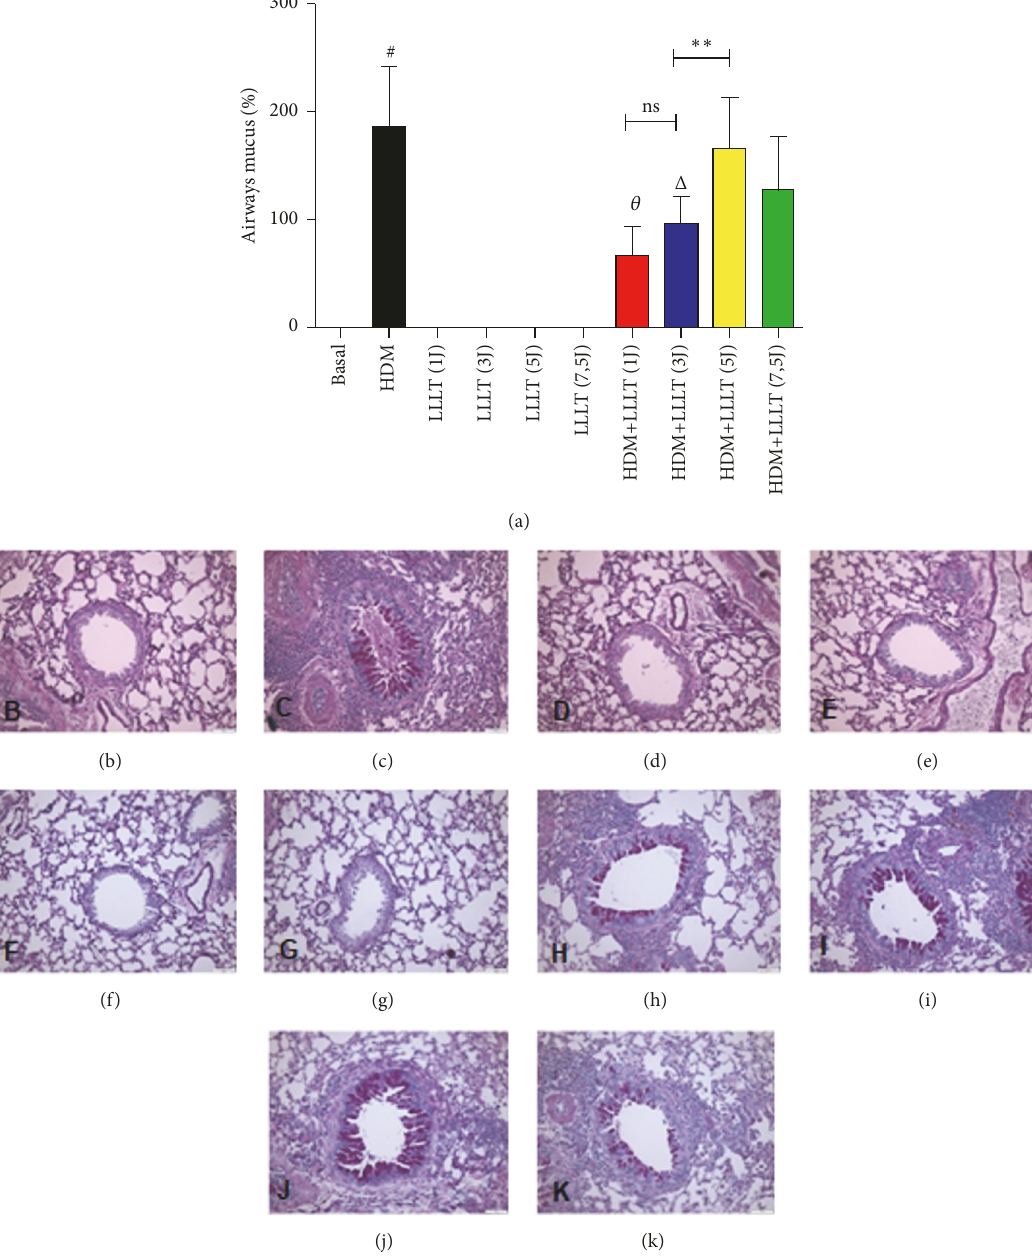
Figure 4: Effect of LLLT on the production of mucus in the airways. The lungs were fixed, prepared, and stained with PAS (Periodic Acid Schif) for the analysis of mucus in the airways. The animals were irradiated with LLLT 3x/week for 5 weeks, 1 hour after challenge with HDM. Increase of × 200. Values expressed as mean and standard deviation. The groups used in the experiment are described in Figure 1. The results refer to the use of 10 mice in each experimental group. # p < 0.001 when compared to the Basal group and Δ p < 0.01 when compared to the asthmatic group (HDM) and ns (not significant); ∗ p < 0,05 and ∗∗ p < 0,01 when compared HDM+LLLT (3J) group with the other groups treated with other